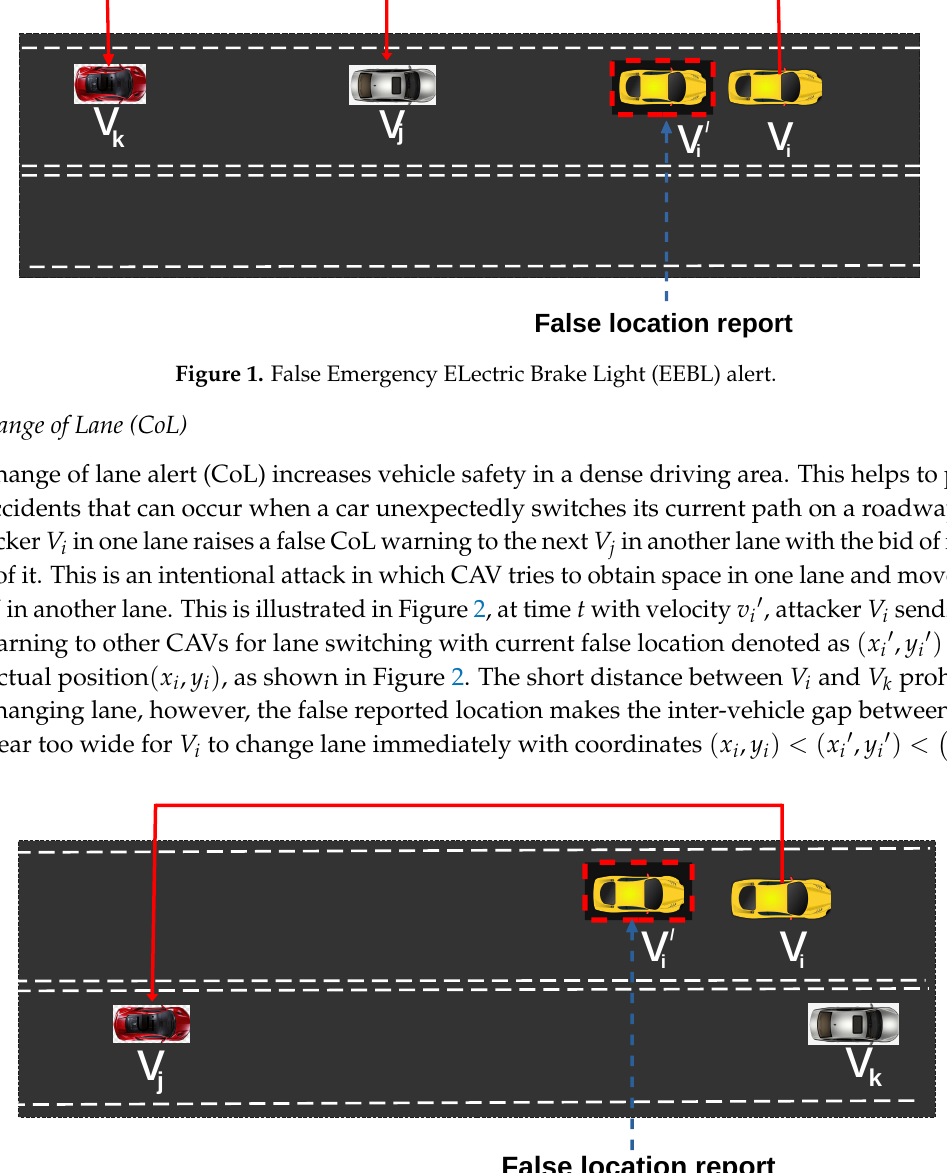
Figure 2. Change of Lane Attack